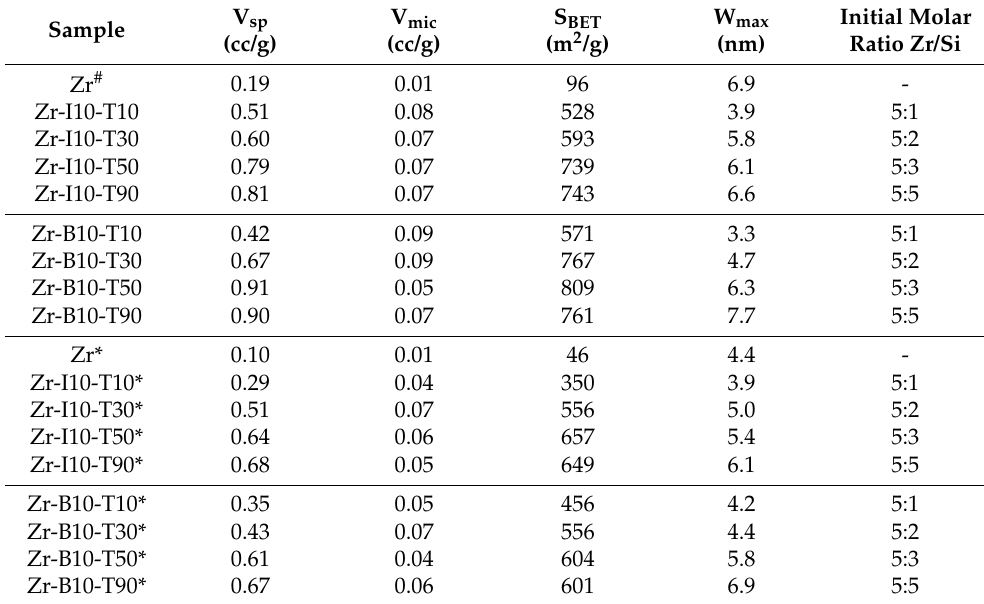
Table 1. Adsorption parameters for Zr-I-PMO and Zr-B-PMO samples